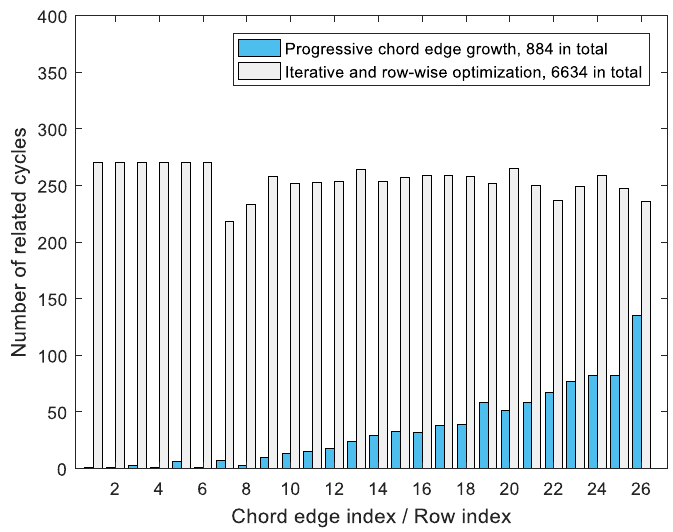
Figure 6. The number of cycles that require the FRC check for each chord edge/row.